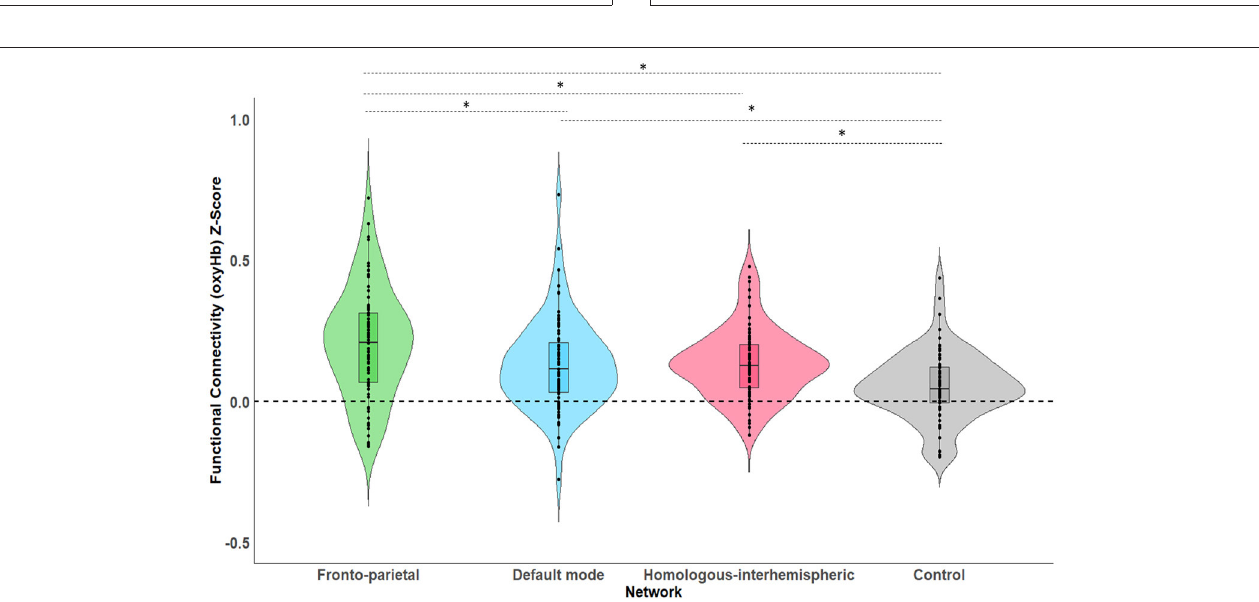
FIGURE 4 | This figure shows the unadjusted (solid line) and adjusted relation (covariates not shown: HIN, Control, maternal education) between functional connectivity (oxyHb) Z-score and regulation/orienting. Here, we found that connectivity in the FPN was positively associated with regulation/orienting ( p = 0.049) whereas, connectivity in the DMN was negatively associated with regulation/orienting ( p = 0.018). Shaded regions represent 90% confidence intervals for the raw (unadjusted)